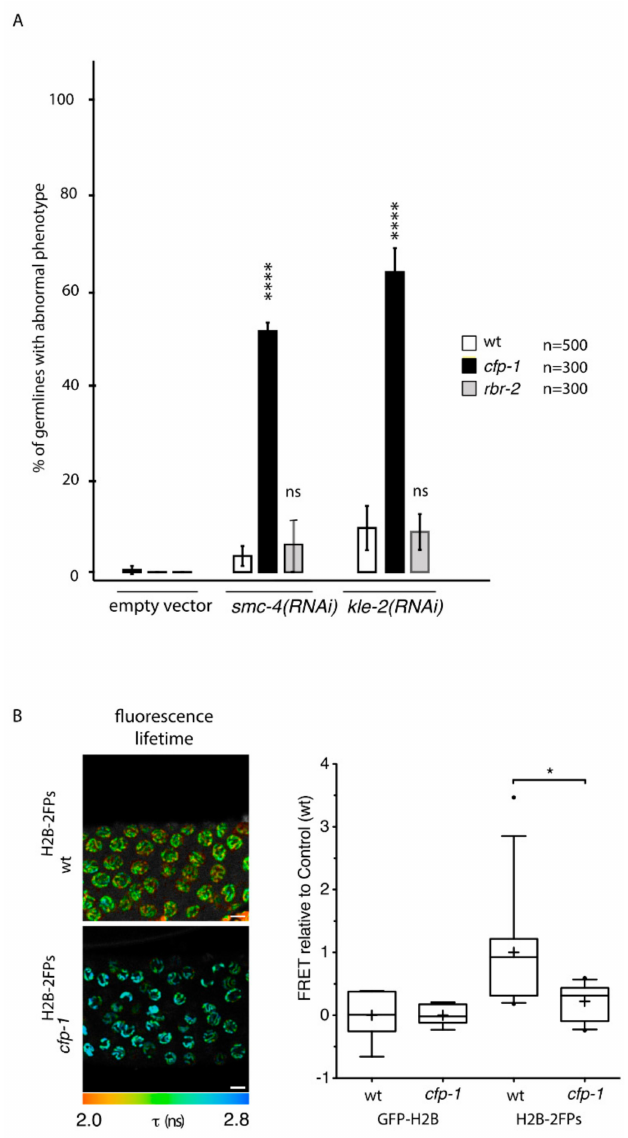
Figure 5. Inactivation of COMPASS targeting component CFP-1 mimics loss of SET-2. ( A ) Percentage of germlines with “strong” phenotype after RNAi directed against condensin-II ( smc-4 or kle-2 ) in wildtype, cfp-1(tm6369) and rbr-2(tm1231) mutants. n = number of animals scored from at least 3 independent experiments. [****] p < 0.0001 ( t -test); ns, not significant. ( B ) Representative fluorescence lifetime images of wt H2B − 2FPs and cfp-1 H2B − 2FPs mutant germlines and fluorescence lifetime values ( τ ). Scale bars, 10 µ m. Box-and-whisker graph plots showing the decrease in FRET e ffi ciency in cfp-1 mutant animals. Mean FRET values ate indicated by a cross in each box. [*] p < 0.05 (two-tailed unpaired t test). n = 13 gonads for wt, n = 11 gonads for cfp-1